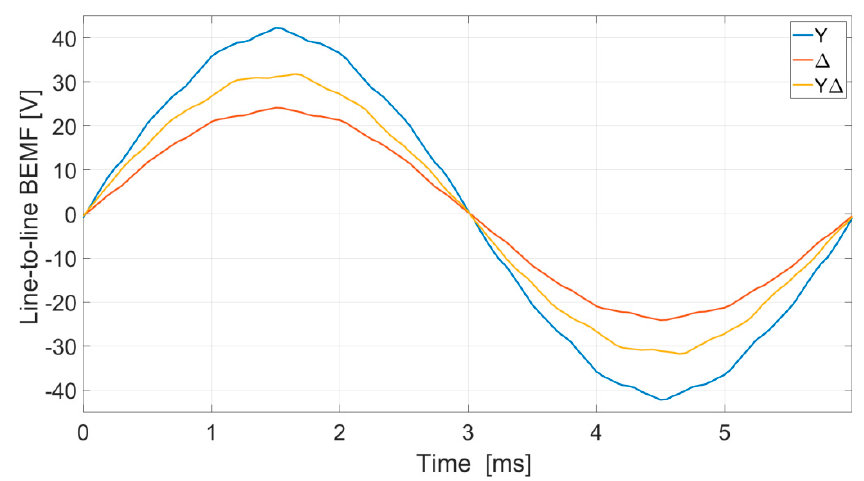
Figure 6. Waveforms of line-to-line BEMF.